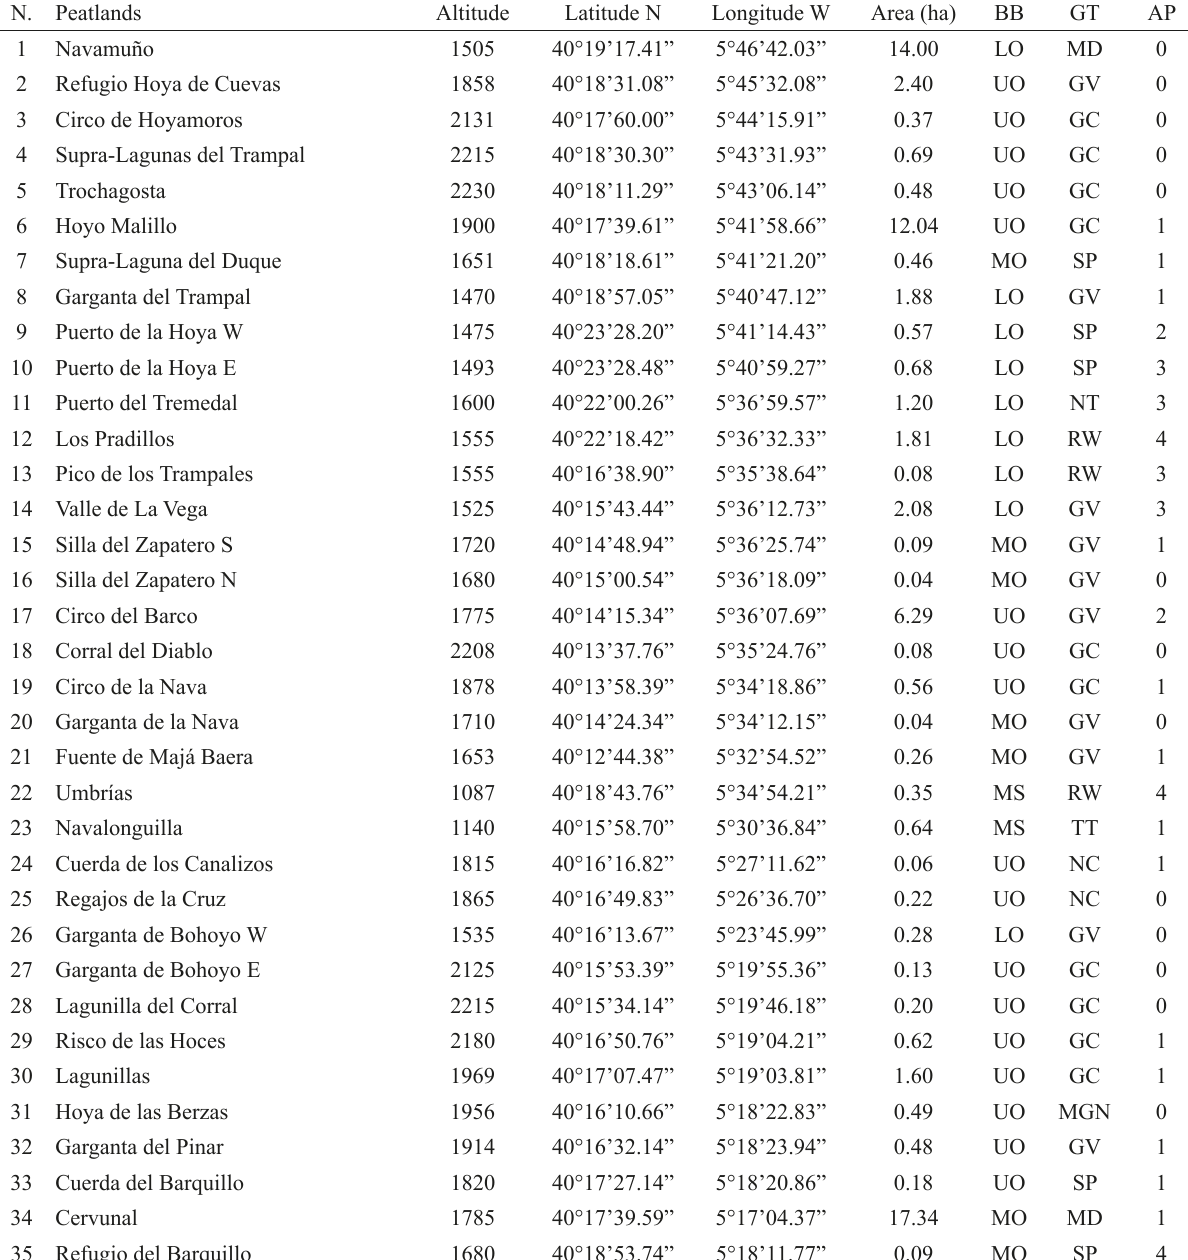
Table 1. Site characteristics for the 72 peatlands on the Gredos Regional Park. Bioclimatic belts (BB): UO, upper orosubmediterranean; MO, middle orosubmediterranean, LO, lower orosubmediterranean, US, upper supramediterranean, MS, middle supramediterranean. Geomorphological typology (GT): Confined peatlands: RW, rock weathering; GC, glacial cirques; GV, glacial valleys; MD, moraine-dammed type; MGN, glacial or nival plugging moraine type; NC, nival cirque-type; NT, nava- type. Unconfined peatlands: S , springs; TT, torrent-type. AP; Anthropic pressure.